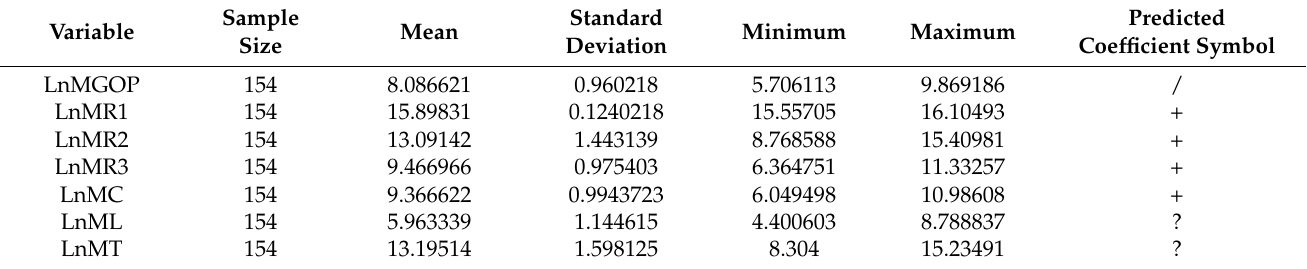
Table 2. Descriptive statistics of the